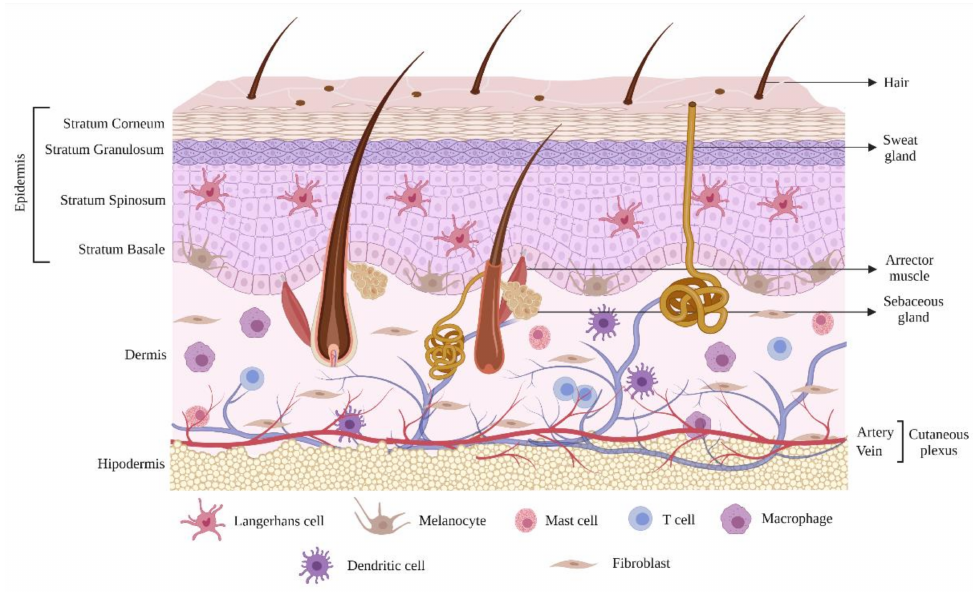
Figure 2. Skin structure and immune cell